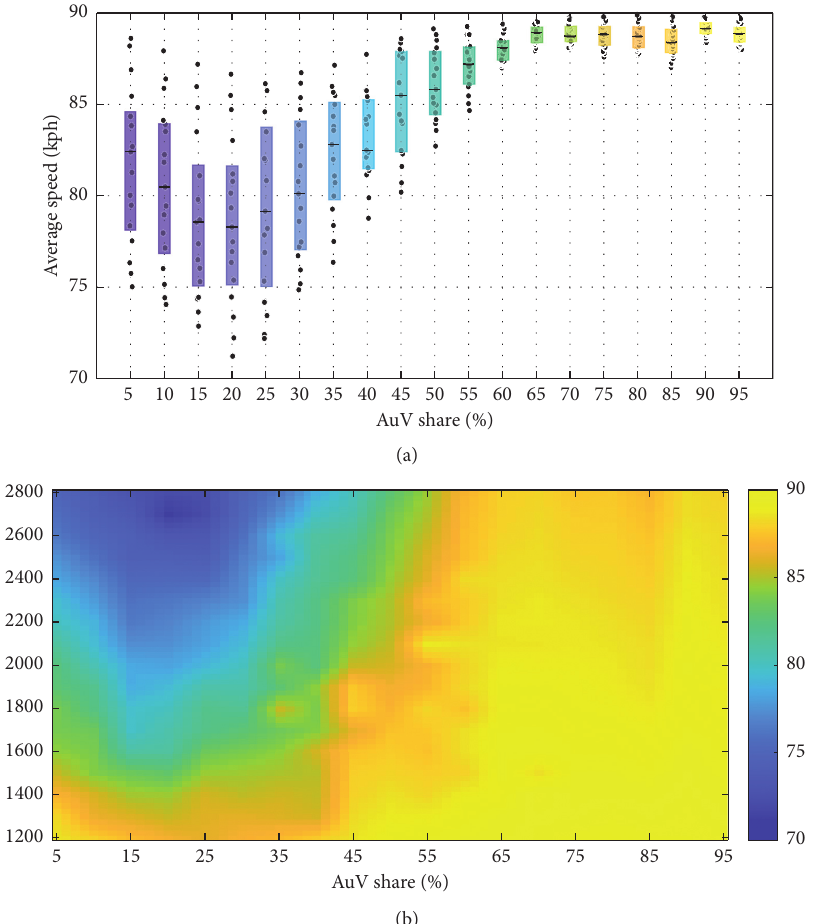
Figure 4: (a) Average speed of weaving section for simulated mixed traffic scenarios; (b) average speed heatmap for varying inflow rates and AuV